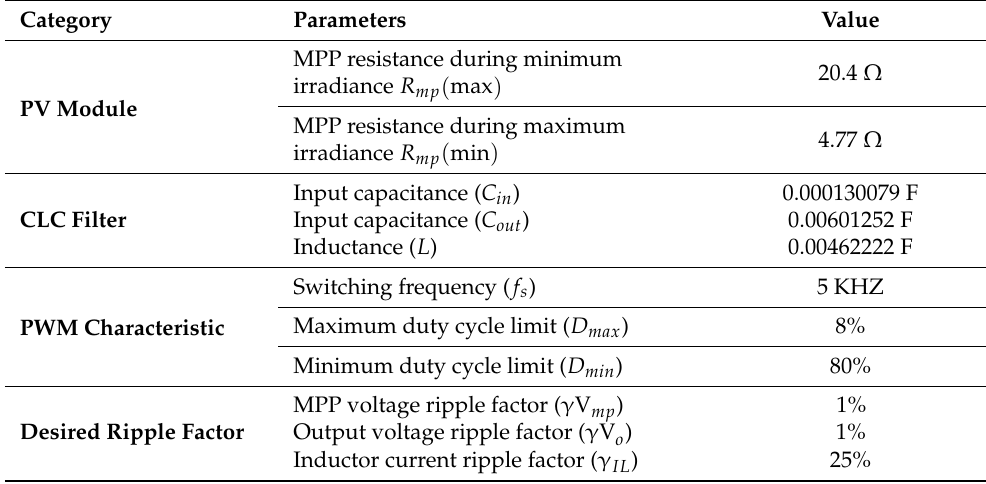
Table 6. Parameters needed to calculate the MPPT boost converter components.